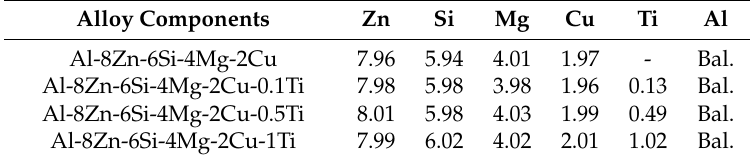
Table 1. Chemical composition of different Ti additions to Al-8Zn-6Si-4Mg-2Cu alloys.